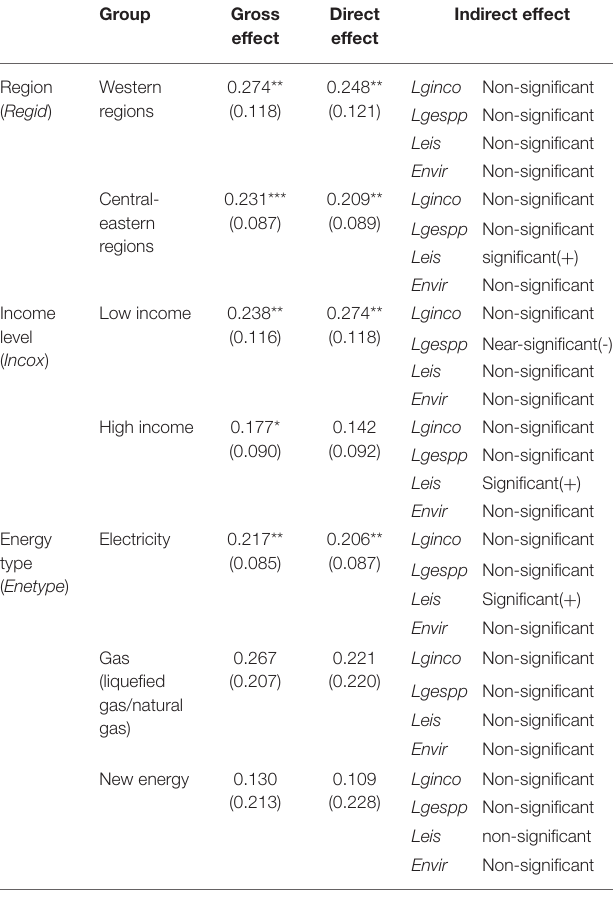
TABLE 4 | The moderation effect of energy consumption revolution on improving farmers’